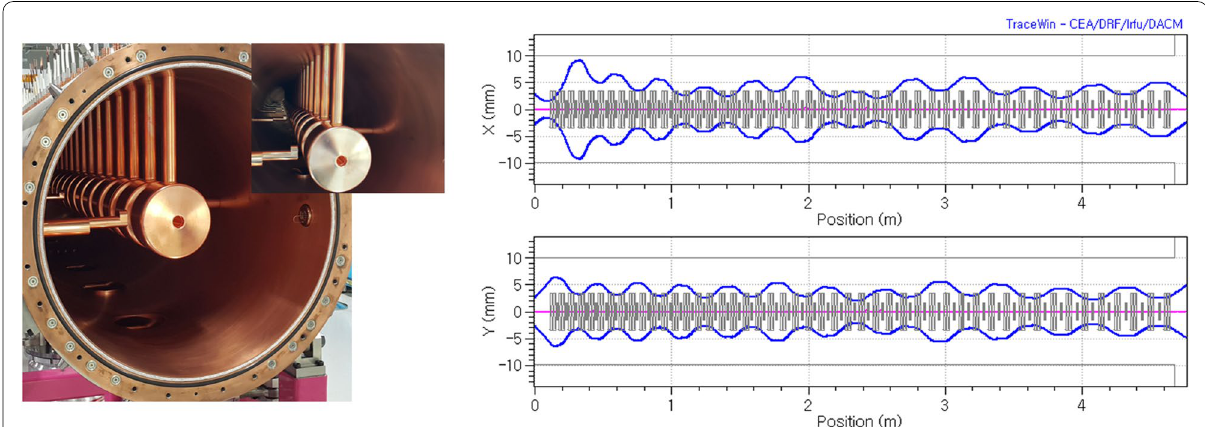
Fig. 11 (Left) Photo of the inner structure of the DTL linac and (right) a beam trace simulation of the output beam from the RFQ into the